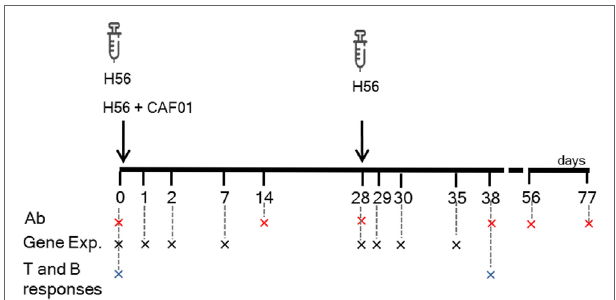
FigUre 1 | Study design and samples collection. C57BL/6 mice were subcutaneously primed with H56 antigen alone or combined with CAF01, and boosted at day 28 with H56. Blood samples were collected at days 0, 14, 28, 38, 56, and 77 for antibody analysis (Ab) and at days 0, 1, 2, 7, 29, 30, and 35 (corresponding to days 1, 2, and 7 after boosting) for gene expression (Gene Exp). dLN and spleens were collected at days 0 and 38 (10 days after boosting) to evaluate the secondary CD4 + T and B cell